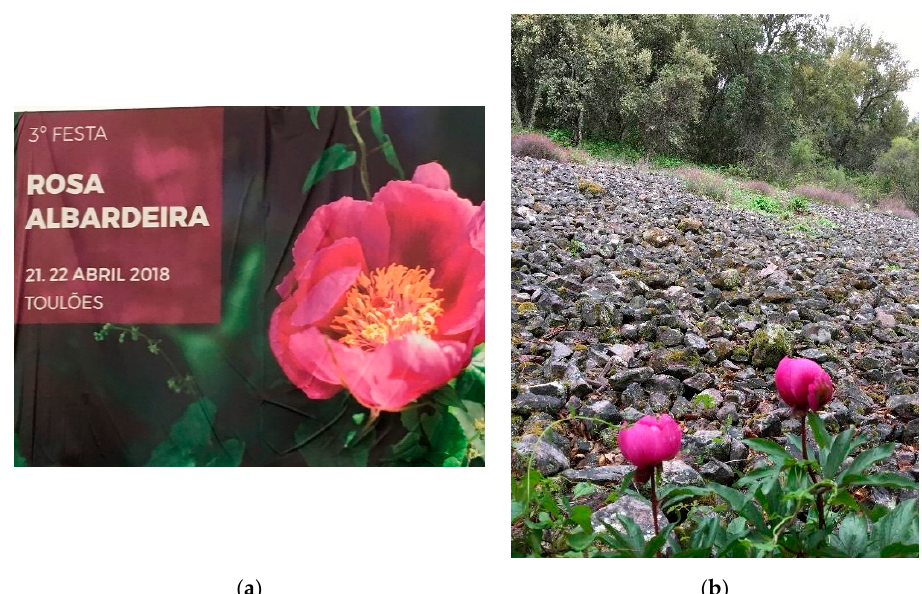
Figure 13. ( a ) Promotion board for the Peony Festival in Naturtejo UGGp in 2018. ( b ) A rocky field forms a peony habitat.